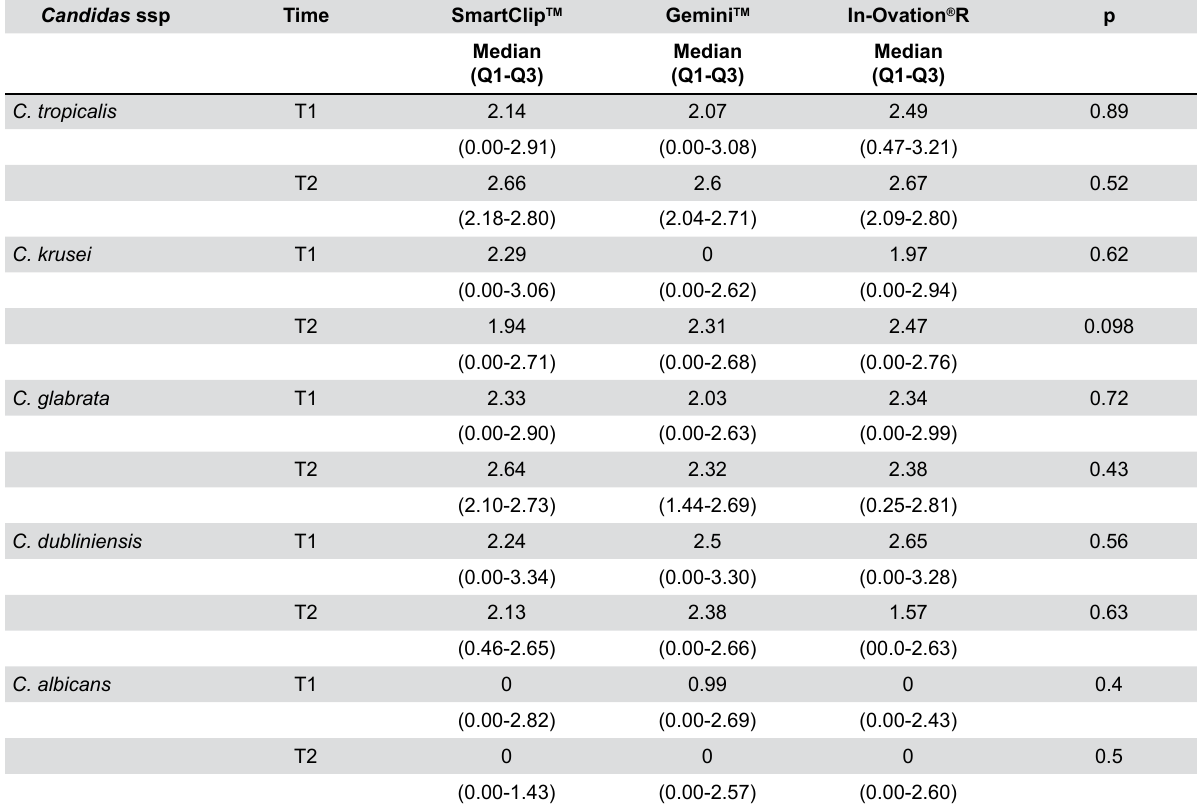
Table 3- Candidas ssp count ( m gx10 5 ) in situ sample